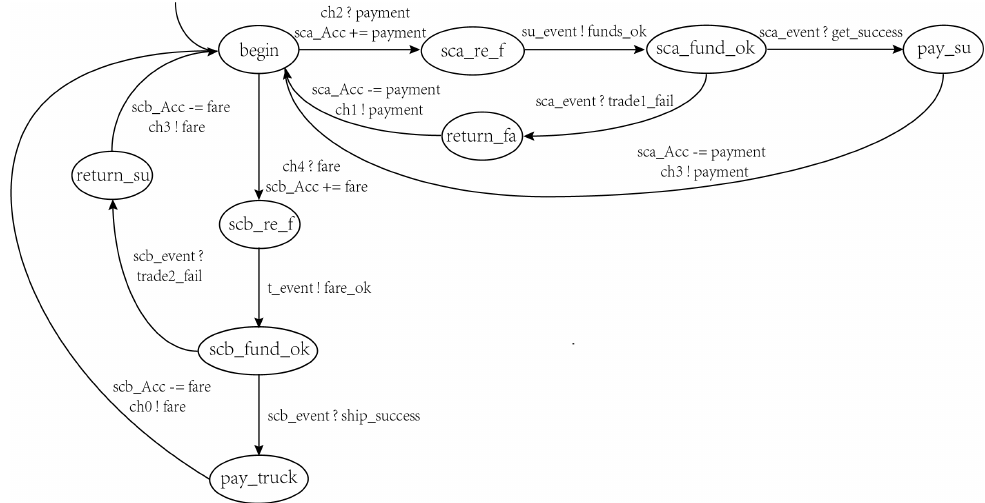
Figure 10. The Ethereum